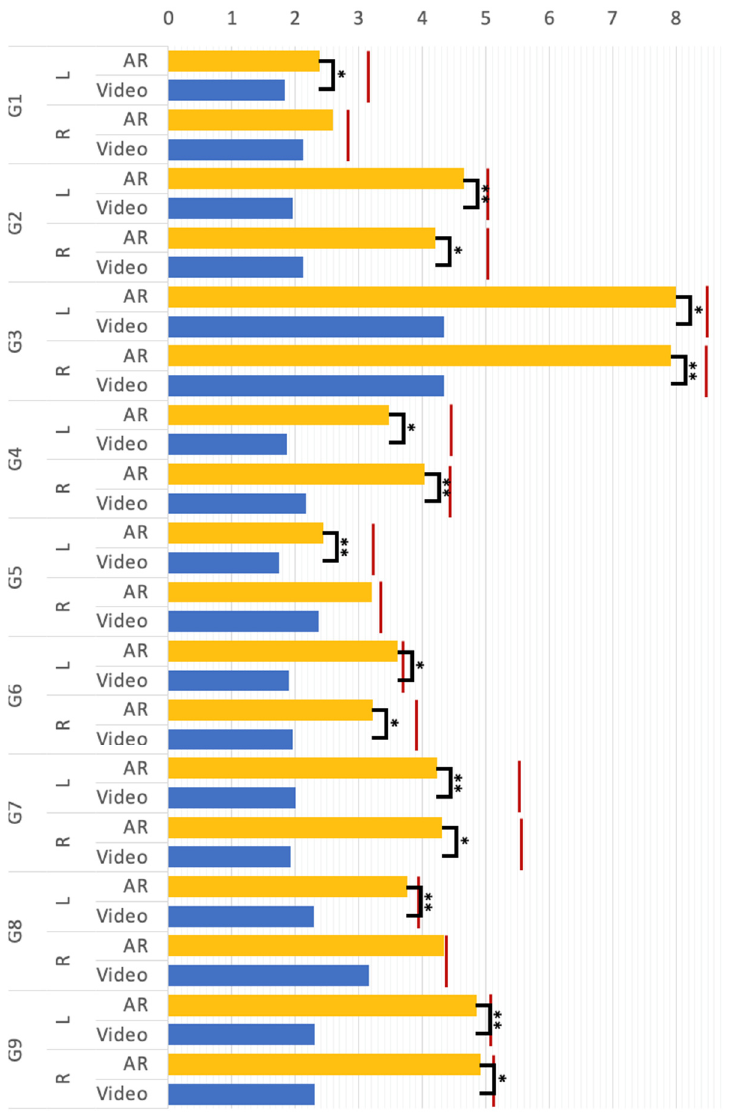
Figure 6. The mean body movement magnitude (** p < 0.01, * p < 0.5); G1 to G1 represent the rehab postures, respectively; “L” and “R” denote the left and right body part; “ Video ” and “ AR ” represent the video and AR rehabilitation conditions; the red lines are the value of the control group.